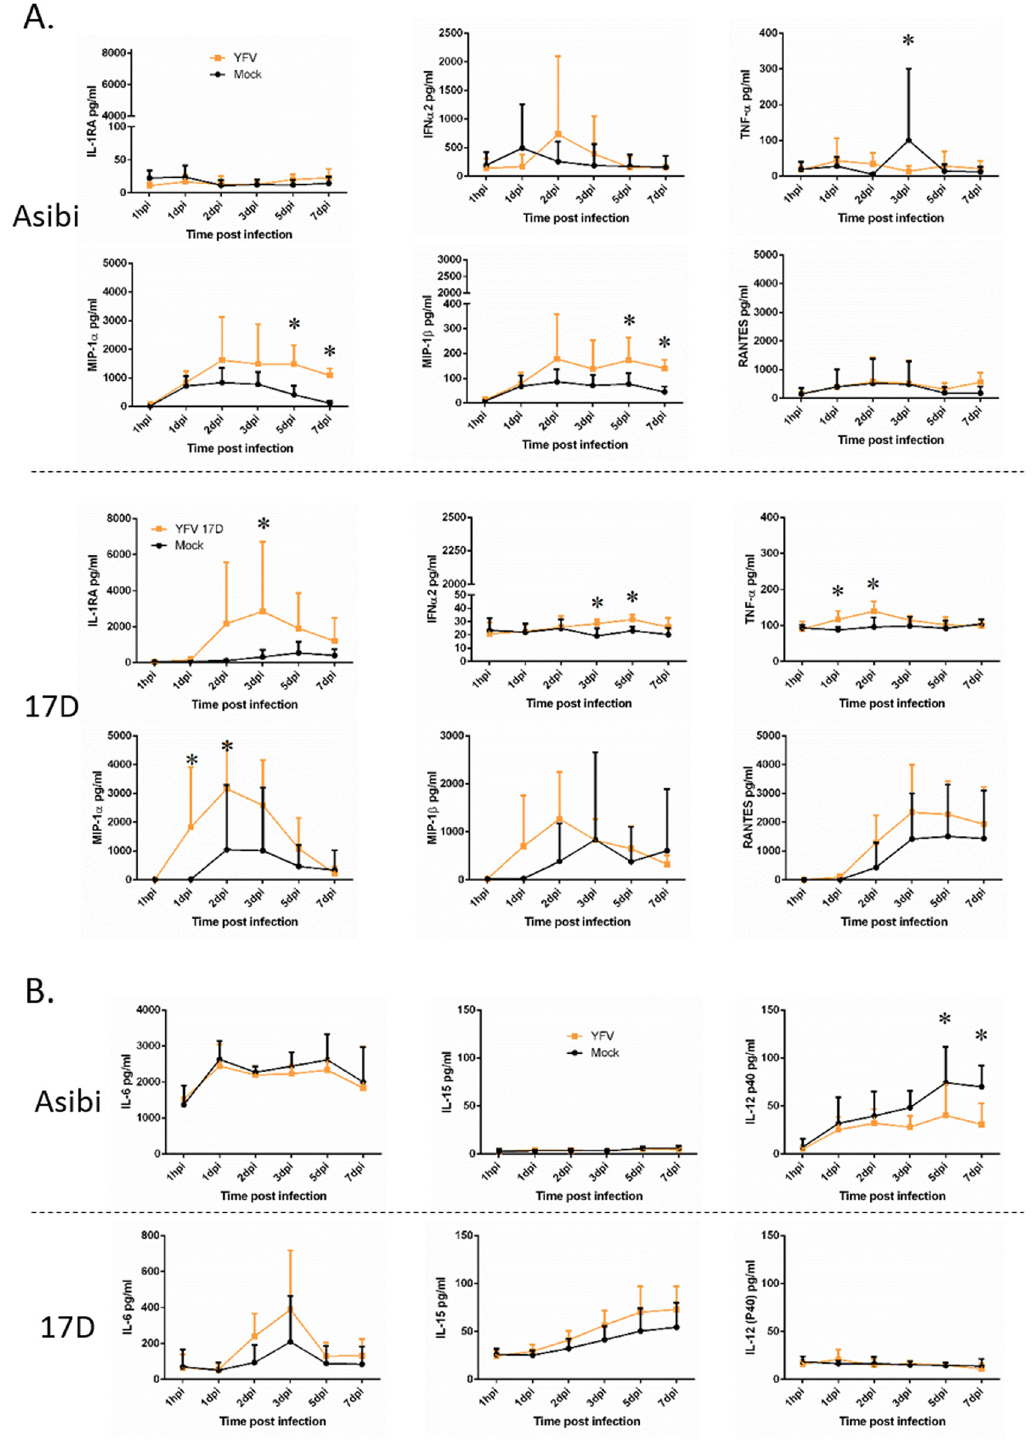
Fig 6. Cytokine and chemokine response in NHP MDM and MoDC. Cytokine and chemokine response in NHP (A) MDM or (B) MoDC infected with either wild-type Asibi virus or the vaccine strain 17D virus (yellow) in relation to mock (black) infected cells. ( * ) indicates points of significant (p < 0.05) difference between virus and mock infected cells. Repeated measures ANOVA run in SAS was used to determine statistical